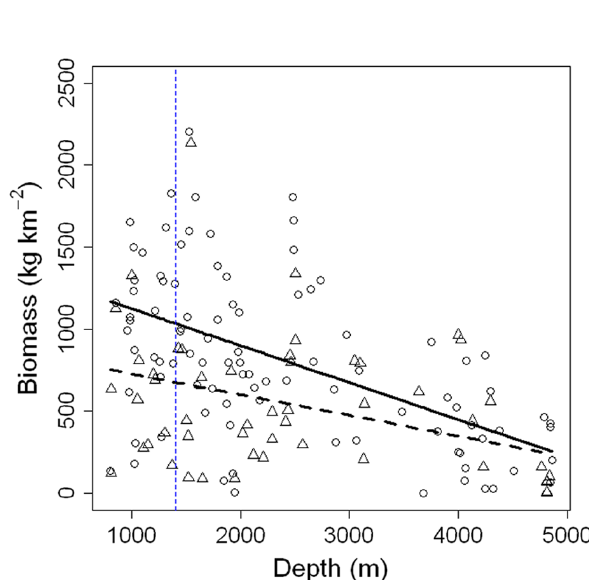
Fig. 2. Changes in total demersal fish biomass (kgkm − 2 ) with depth in the Porcupine Seabight and abyssal plain area of the North- east Atlantic Ocean between the early (1977–1989, circles) and late (2000–2002, triangles) trawling periods. Model predictions for changes in total biomass with depth in the early (solid line) and late (dashed line) period. The vertical dashed line represents the approx- imate maximum depth of commercial fishing in this